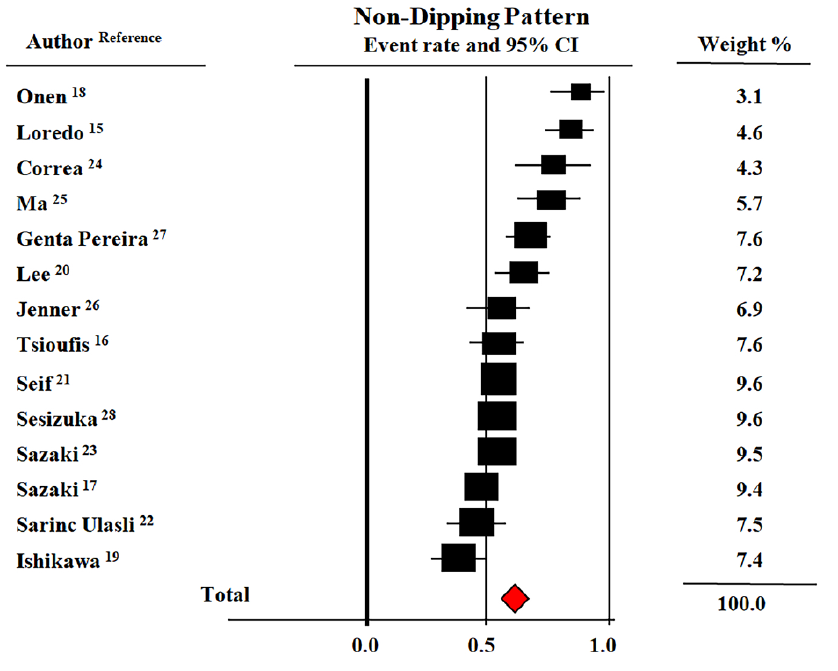
Figure 2. Forest plot of prevalence rates of a non-dipping pattern during 24-hour blood pressure monitoring in patients with obstructive sleep apnea (OSA) [15 – 28]. Data from 14 studies and 1562 participants. Random model ( I 2 = 79%).